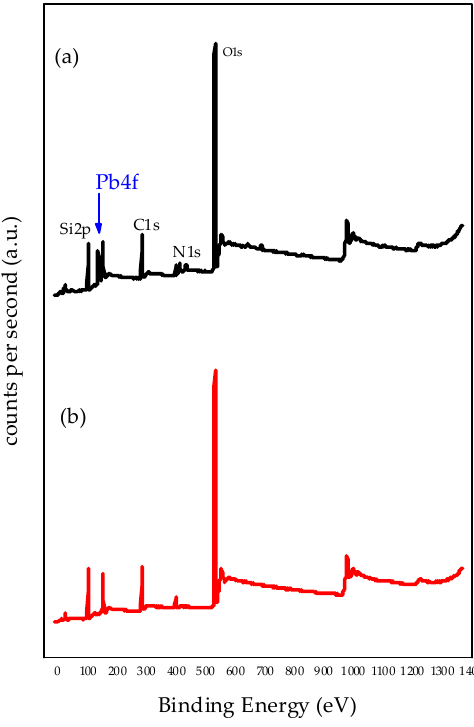
Figure 9. X-ray Photoelectron Spectroscopy wide-scan spectrum of 0.3NH 2 / DMS-1 adsorbent from solution with 100 ppm of Pb(II) ions: ( a ) After lead ion adsorption, and ( b ) before lead ion adsorption Table 2. Binding energy (eV) values of core-electrons from the detected elements, their assignments and surface atomic ratios of 0.3NH 2 / DMS-1 adsorbent before and after Pb(II) Before After XPS Data Adsorption (eV) Adsorption (eV) Si 2p 102.88